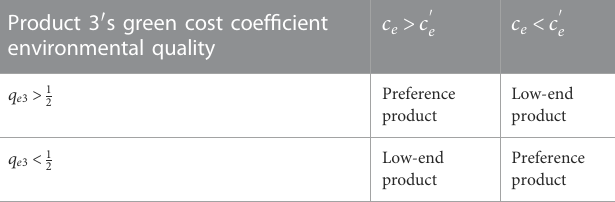
TABLE 4 Product 3 ’ s market positioning in the marketplace with